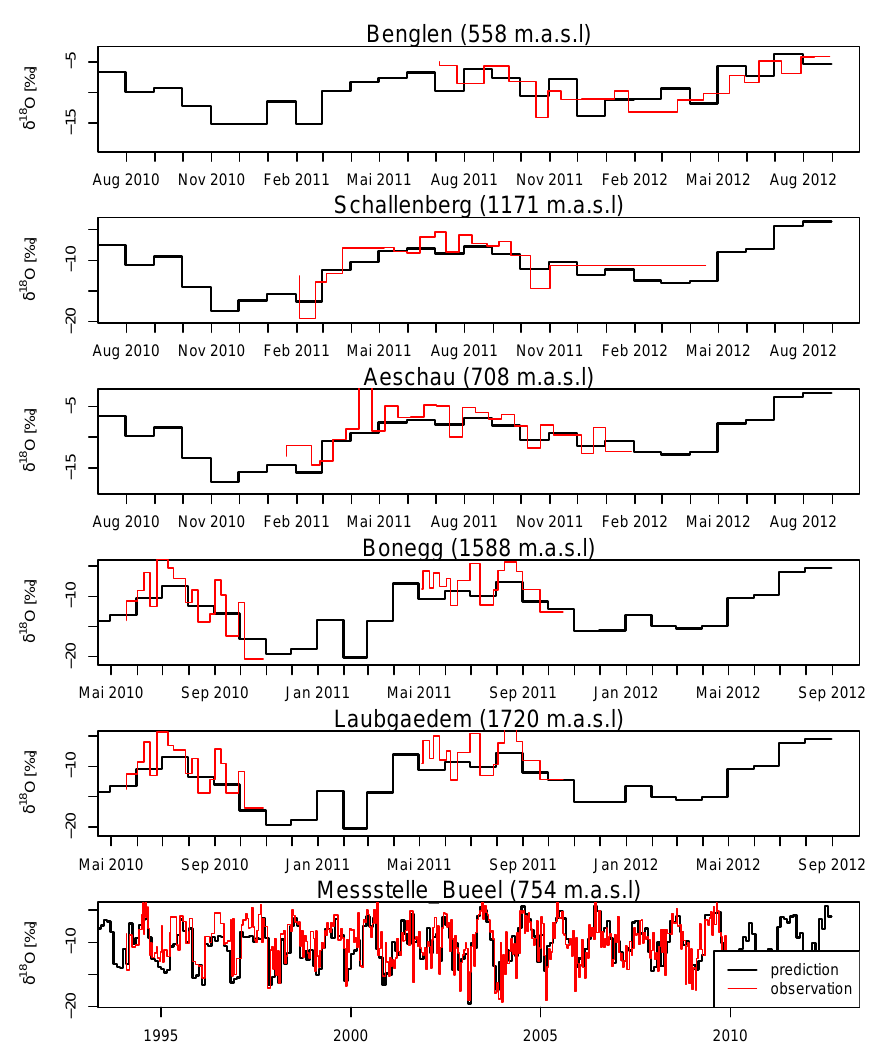
Figure A1. Comparison of measured δ 18 O values (red lines) in precipitation and values obtained by the spatial interpolation method (black